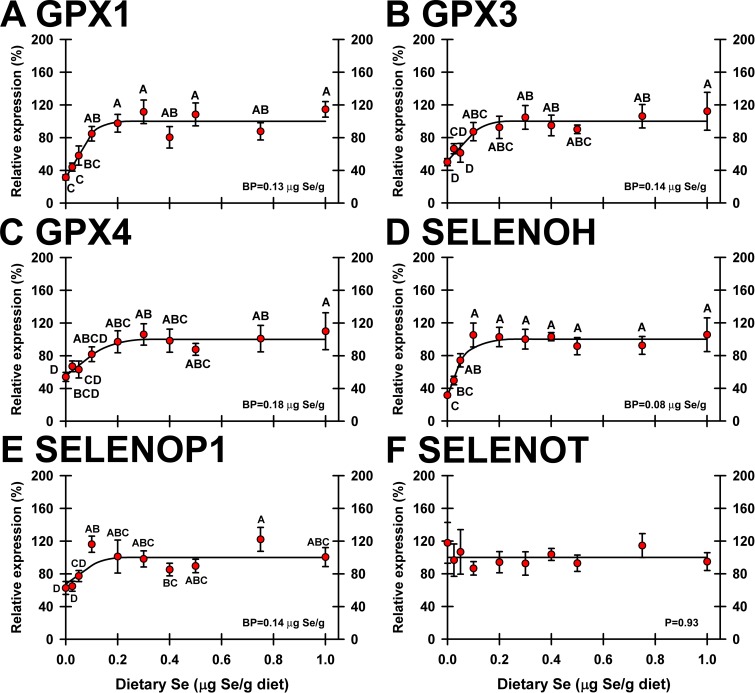
Effect of dietary Se on significantly-regulated selenoprotein transcripts in turkey heart.Plotted are relative transcript levels for GPX1 (A), GPX3 (B), GPX4 (C), SELENOH (D), SELENOP1 (E), and SELENOT (F) in poults supplemented with graded levels of dietary Se for 28 d. Values shown are means ± SEM (n = 5/treatment). Means without a common letter are significantly different (p<0.05). Overall levels of significance, as determined by ANOVA, are given in Table 1. Se response curve breakpoints (BP) are calculated as described in text. SELENOT is an example of transcript expression not significantly regulated by dietary Se.